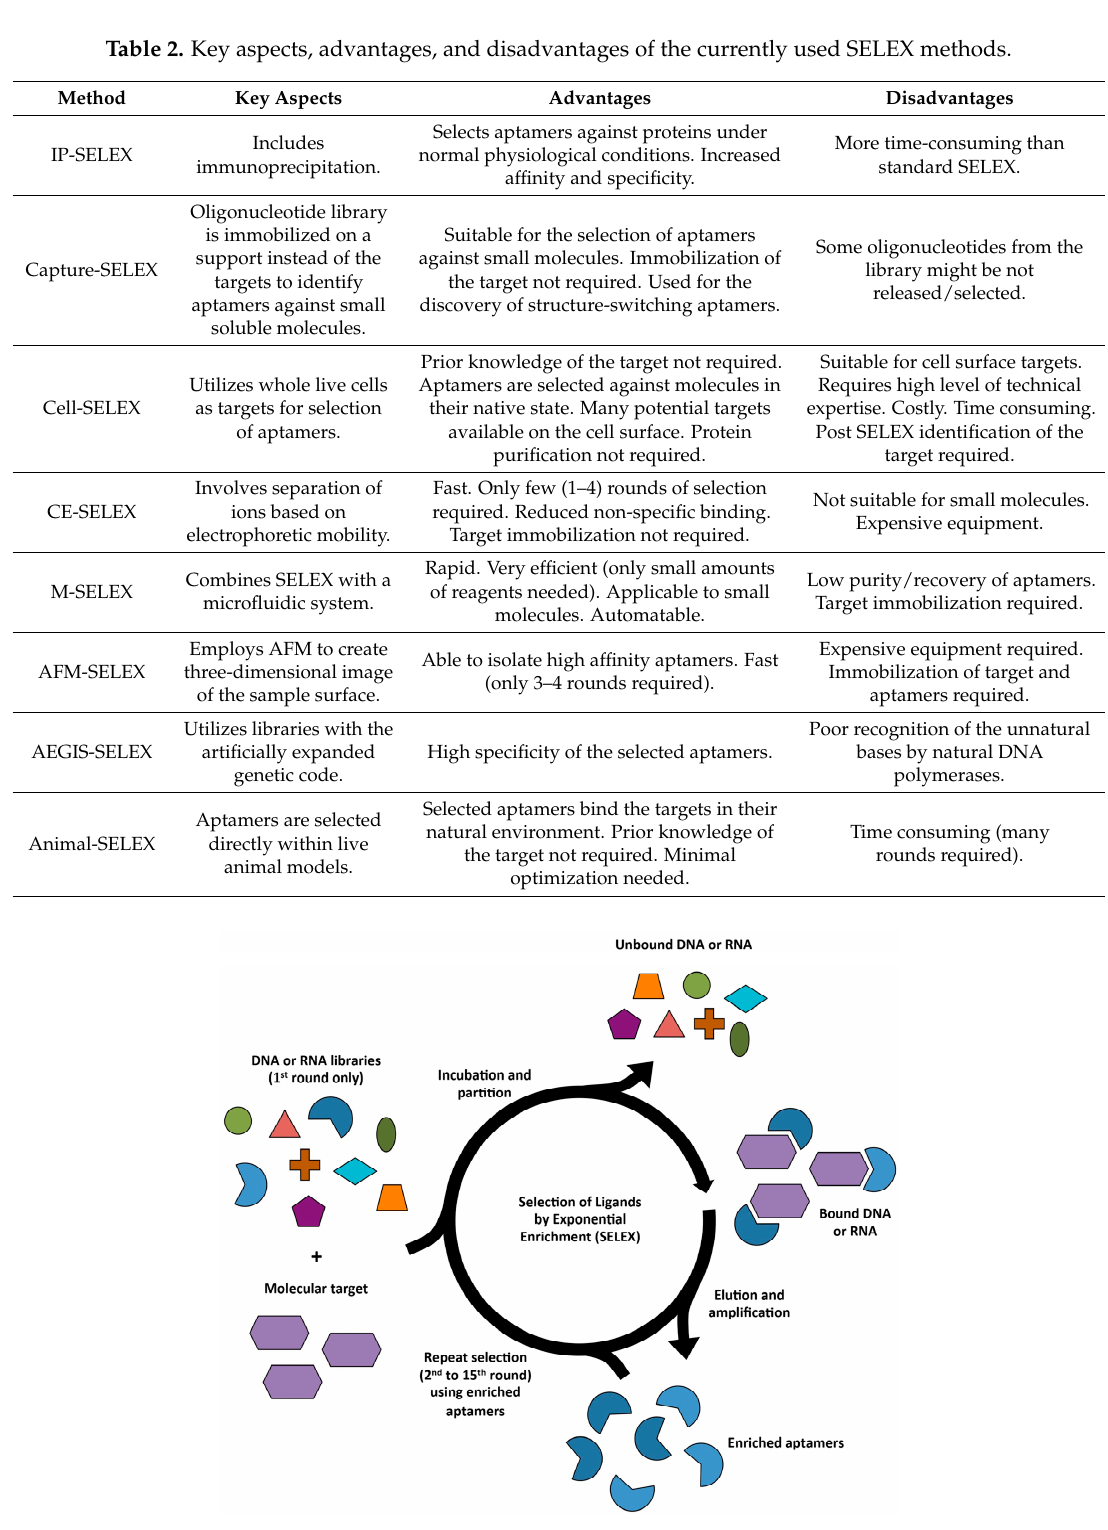
Figure 1. Schematic representation of SELEX (Systematic Evolution of Ligands by EXponential Enrichment). The starting single-stranded DNA or RNA library (10 14 ~10 16 random oligonucleotides) is composed of sequences 20~100 nucleotides in length with a random region in the middle flanked by fixed primer sequences. After incubation with the target of interest, the bound oligonucleotides are partitioned from unbound sequences and amplified by PCR. The resulting enriched DNA pool is used for the next round of selection.